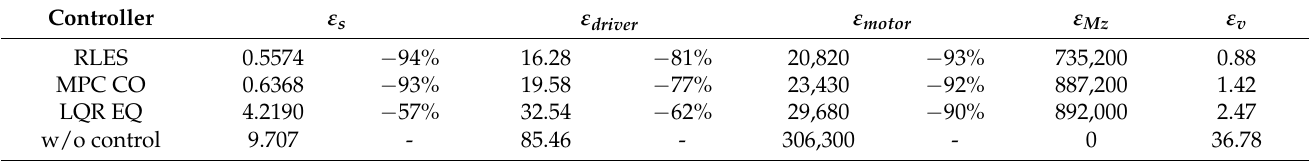
Table 3. Performance indicators in DLC maneuver on joint